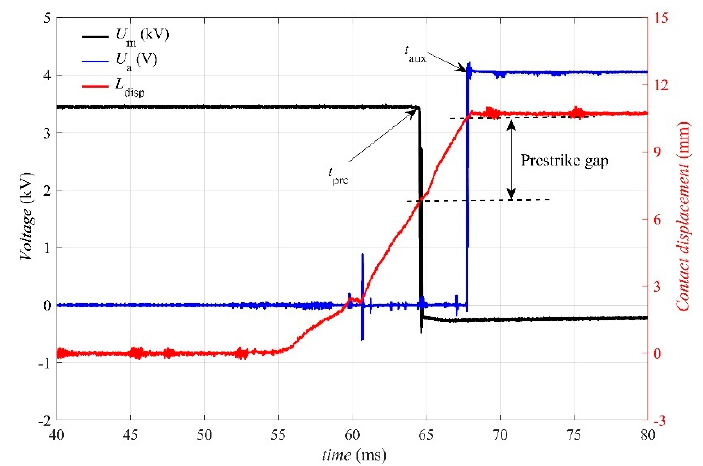
Figure 3. Example of the waveforms of voltages U m and U a and the moving.